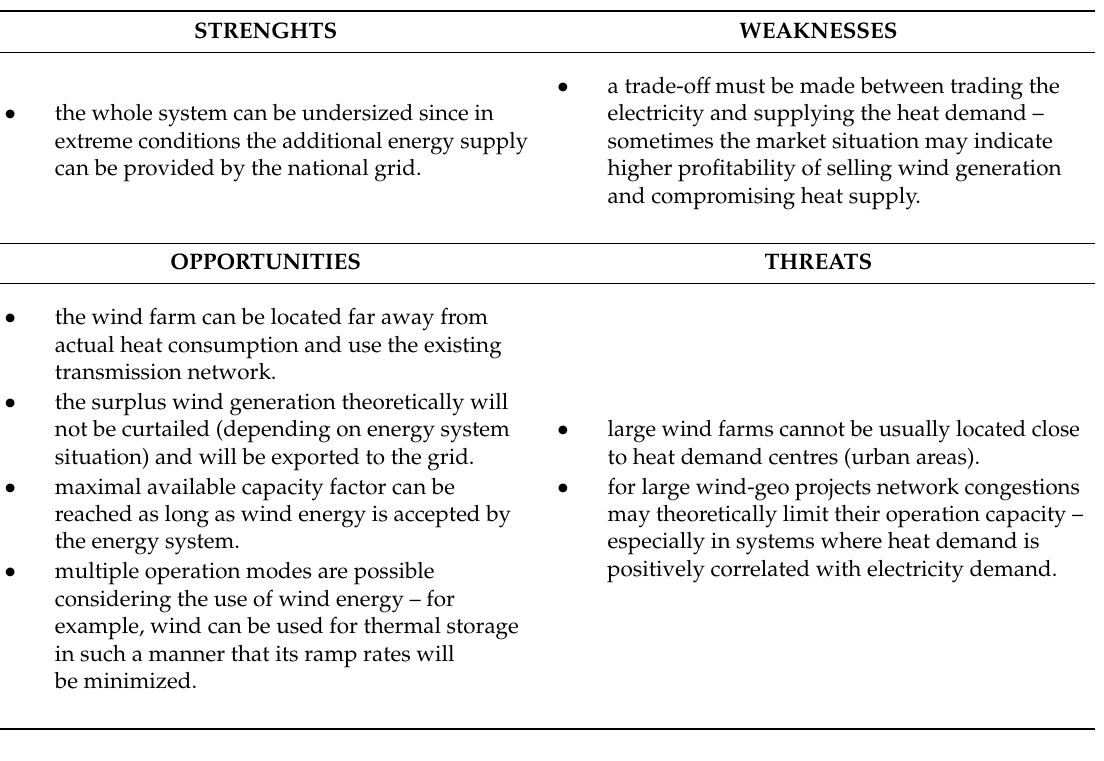
Table 2. SWOT analysis on the potential of on-grid wind-geo district heating system